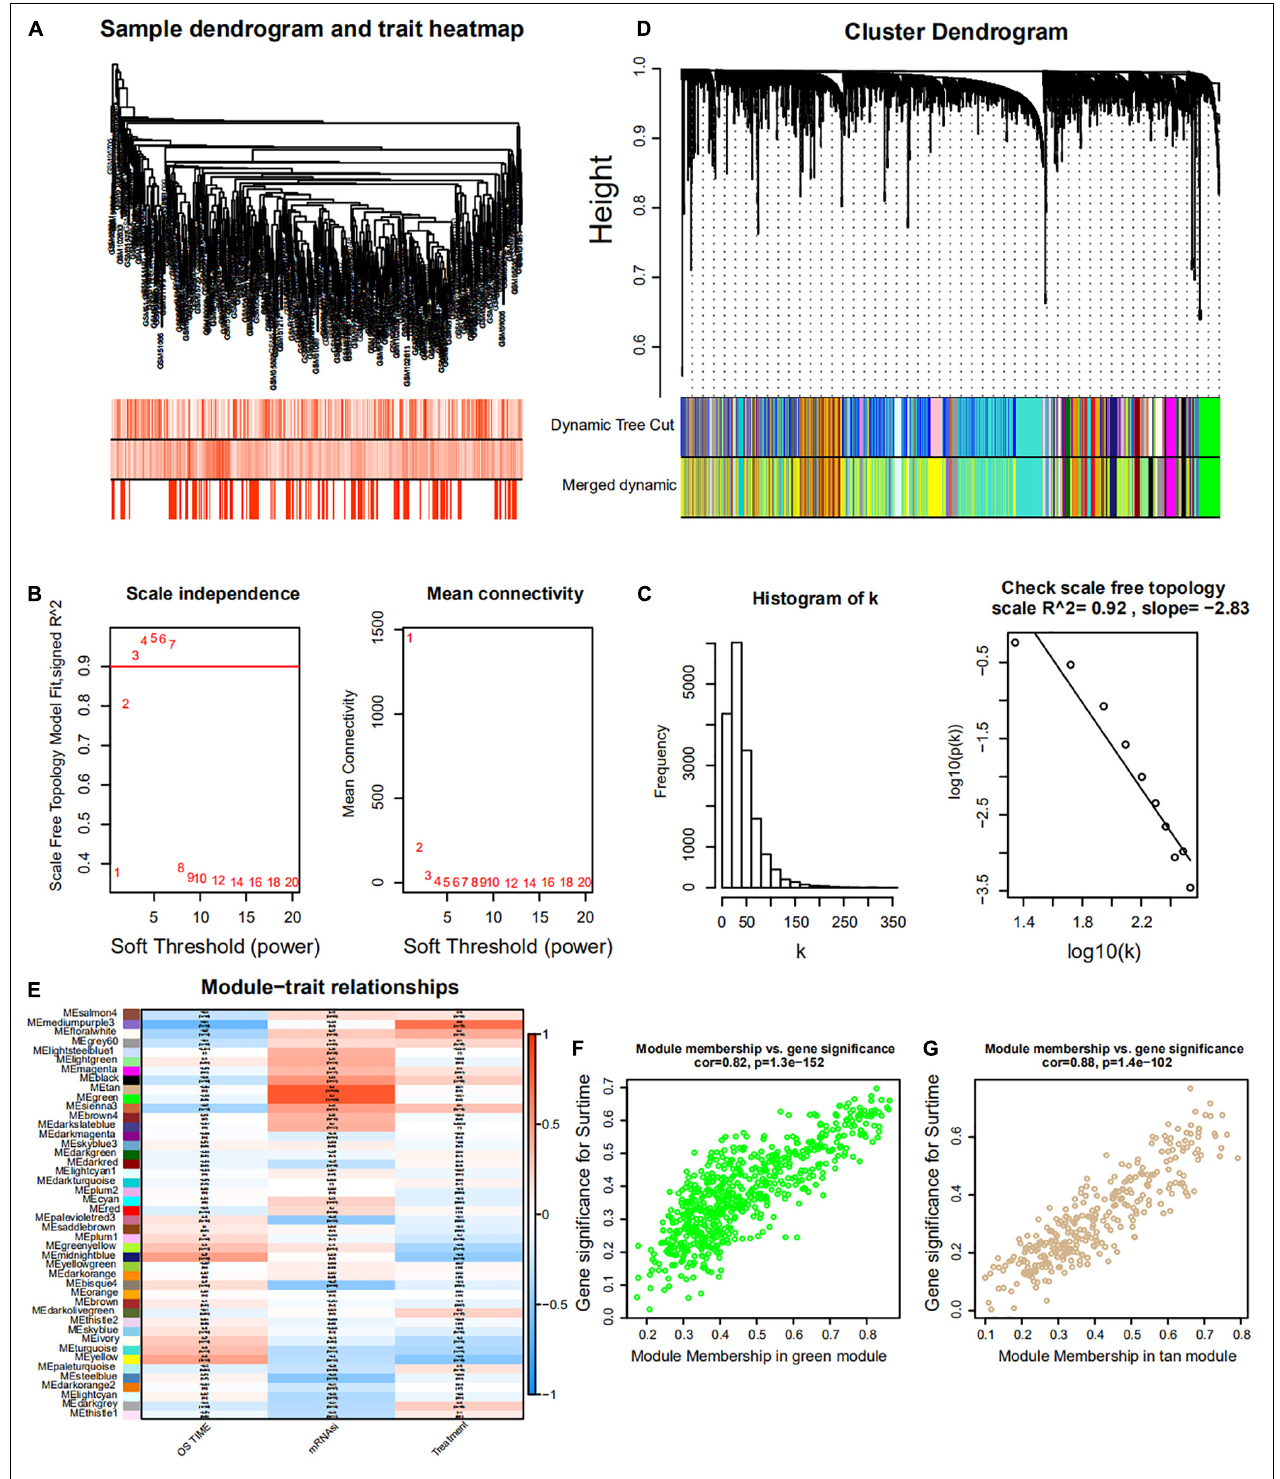
FIGURE 6 | Weighted gene co-expression network of MM of the GSE4204 cohort. (A) Sample dendrogram and trait heatmap. The colors represent the proportion to clinical traits. (B) Left panel: the scale-free topology fit index for soft-thresholding powers. Right panel: mean connectivity for soft-thresholding powers. (C) Scale-free R 2 ( R 2 = 0.92). (D) Clustering dendrogram of gene in patients with MM. (E) Pertinence between clinical traits and gene modules. (F,G) Scatter plots of GS for mRNAsi corresponding to module membership in green and tan modules, with their correlation coefficients and P